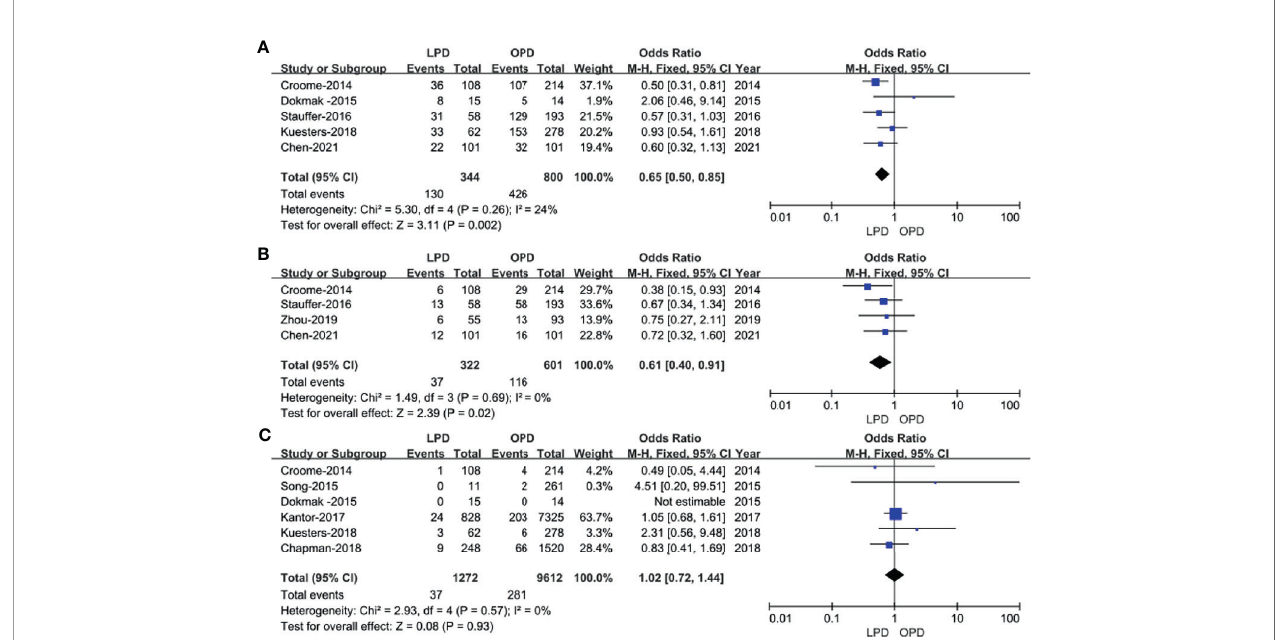
FIGURE 3 | Forest plot of the comparison of LPD versus OPD for postoperative outcomes. (A) Forest plot for overall complication rates; (B) forest plot for Clavien – Dindo grade ≥ III; (C) forest plot for 30-day